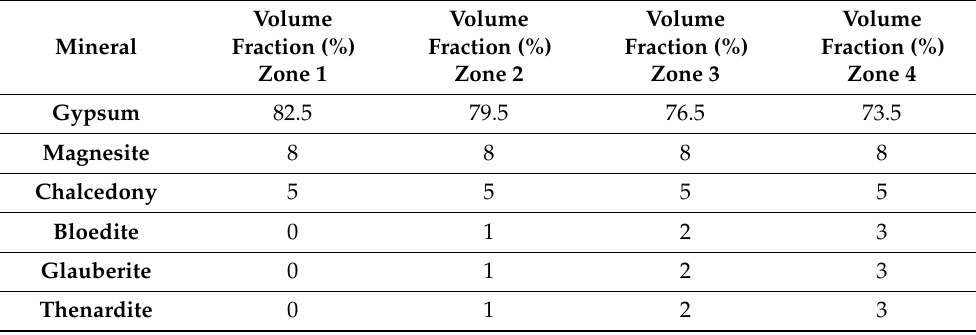
Figure 3. Finite element grids of the 2-D reactive transport models of scenarios 3 ( left ) and 4 ( right ), which differ in the lengths of the mineral zones 2, 3, and 4. Table 4. Initial mineral volume fractions in the mineral zones of the 2-D reactive transport models used in scenarios 3 and 4 (Figure